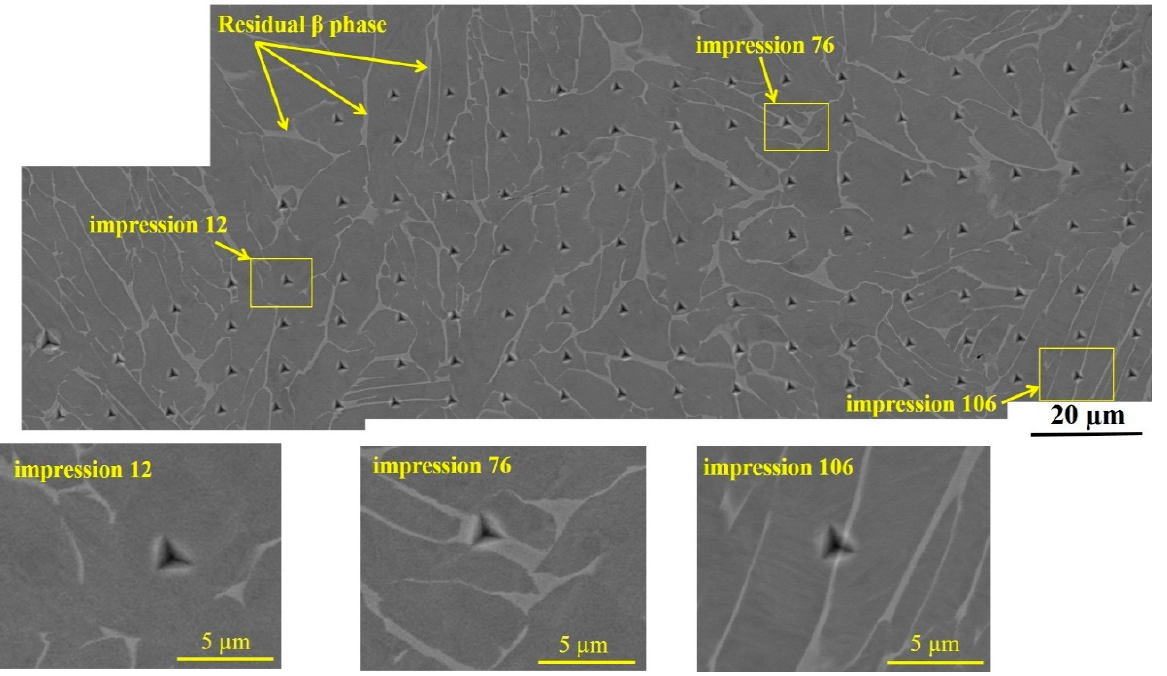
Figure 11. Backscatter electron images of 120 indents on the PM sample in unetched